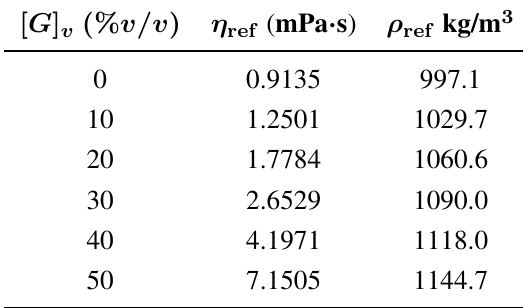
and density ρ are listed for different ref ref used at a temperature of 24 ◦ v